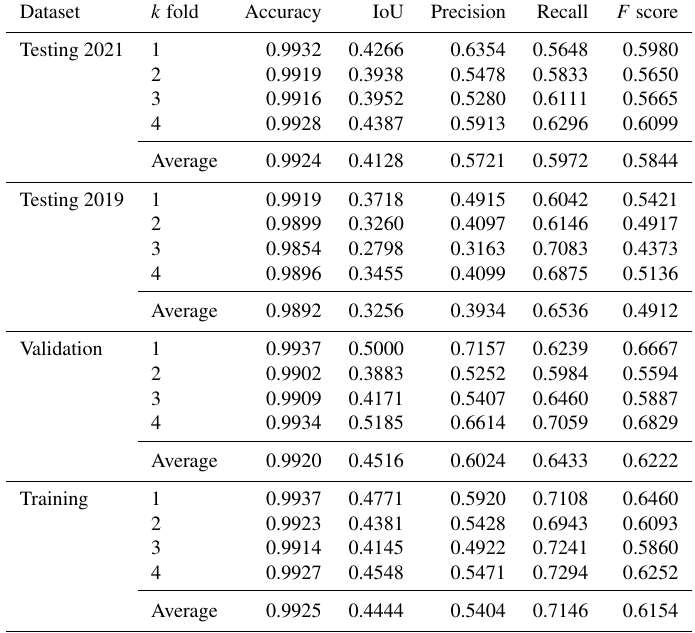
Table A6. Full performance metrics for the green roof identification method, calculated based on building